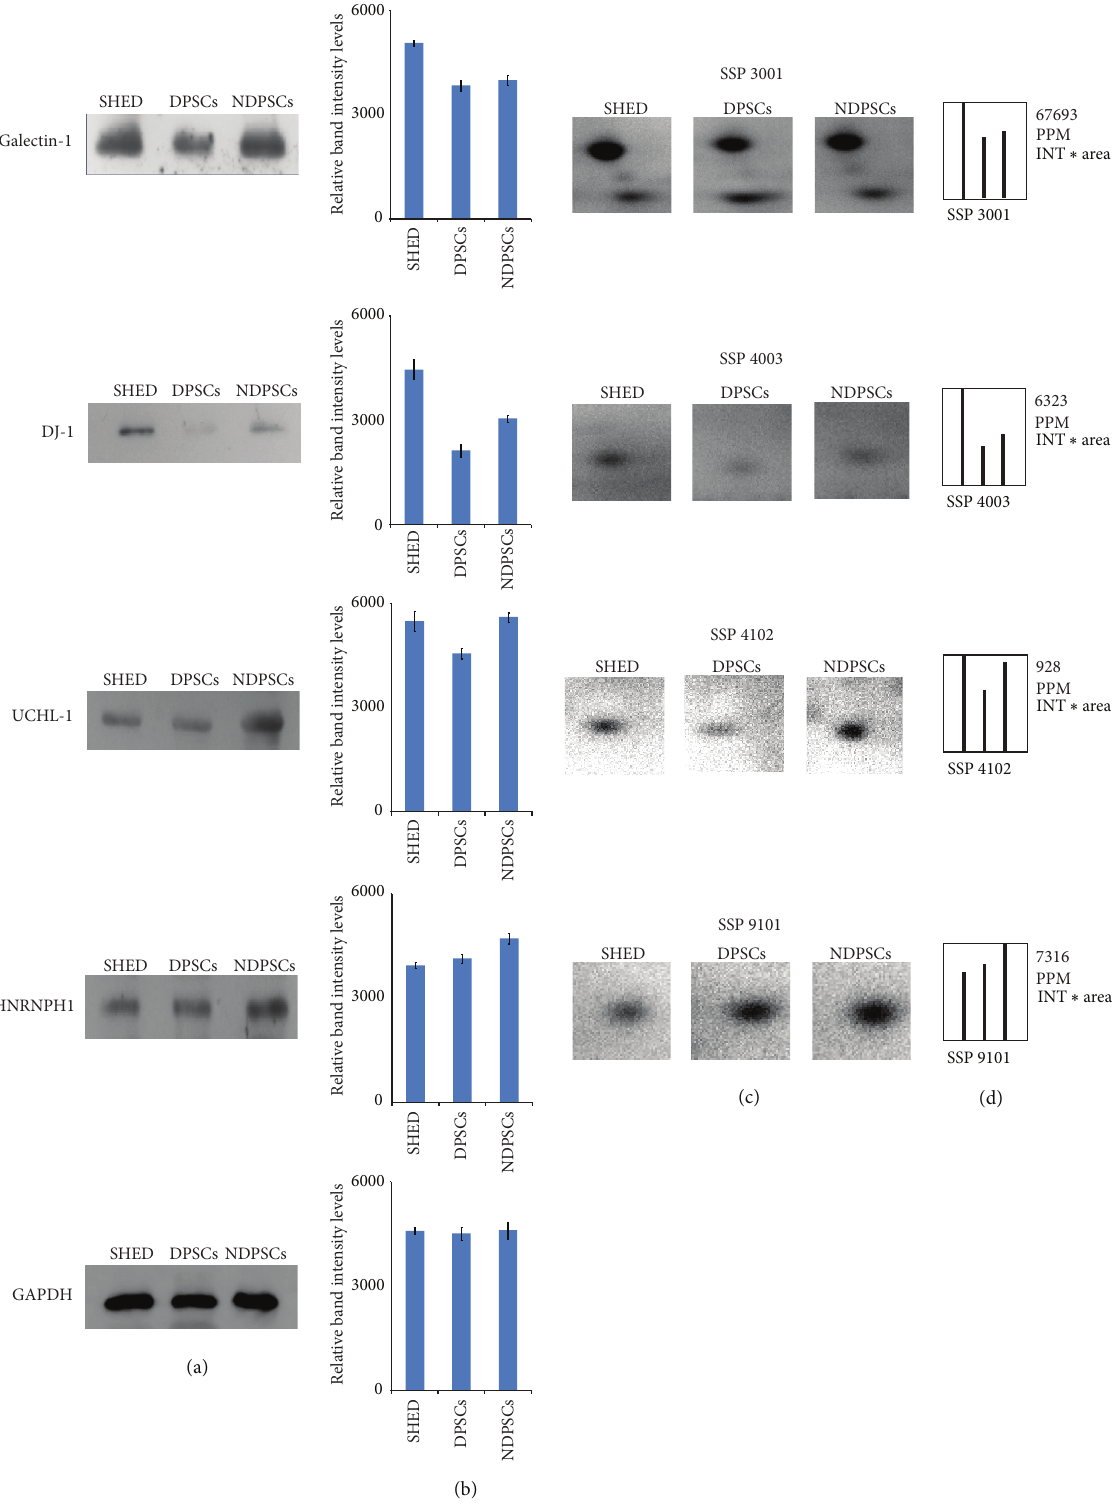
Figure 7: WB validation of the selected proteins identified by MALDI-TOF/TOF analysis. Western blot analysis was used for validation of proteomic results. Conventional 12% SDS gels were run with whole cell extracts. (a) Three lanes for SHED, DPSCs, and NDP-MSC are shown for each antibody. Galectin-1, DJ-1, UCHL-1, and HNRNPH1 antibodies were used for validation of expressions of the identified proteins. GAPDH was used for the normalization of each protein sample. (b) Relative protein intensities of bands were measured by Quantity One 1D analysis software (Bio-Rad). Each WB was repeated for three times. (c) Representative images of protein spots selected for WB analysis (protein identities corresponding to SSP numbers can be found in Table 2). (d) Comparative intensity graphs of selected protein spots generated by PDQuest Advance software